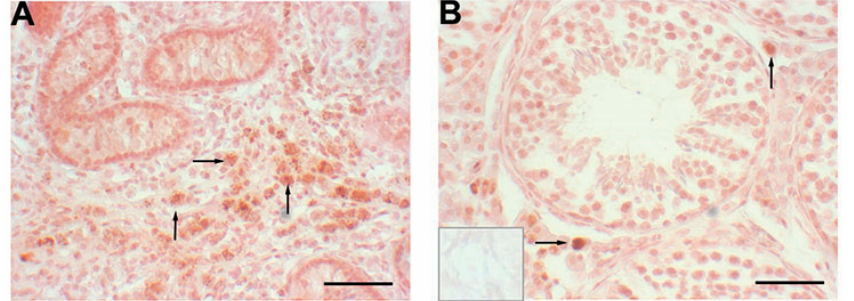
Figure 4. Localization of SRD5A2 protein in testes from a 6.5-week-old boar ( A ) or a 20-week-old boar ( B ). Arrows point to some of the labeled cells. Inset is a normal serum control and is similar to the serum control at 6.5 weeks of age. Scale bar is 50 μ m.